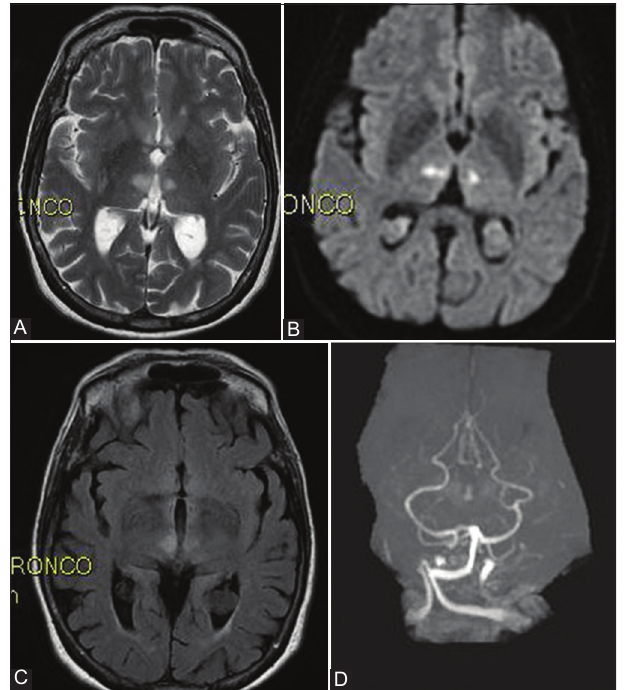
FIGURE 1. (A) T2 FRFSE sequence: Bilateral thalamic infarction. (B) Diffusion-weighted imaging sequence: Bilateral thalamic infarction. (C) T2 flair: Bilateral thalamic infarction. (D) Angio-magnetic resonance imaging: Normal basilar